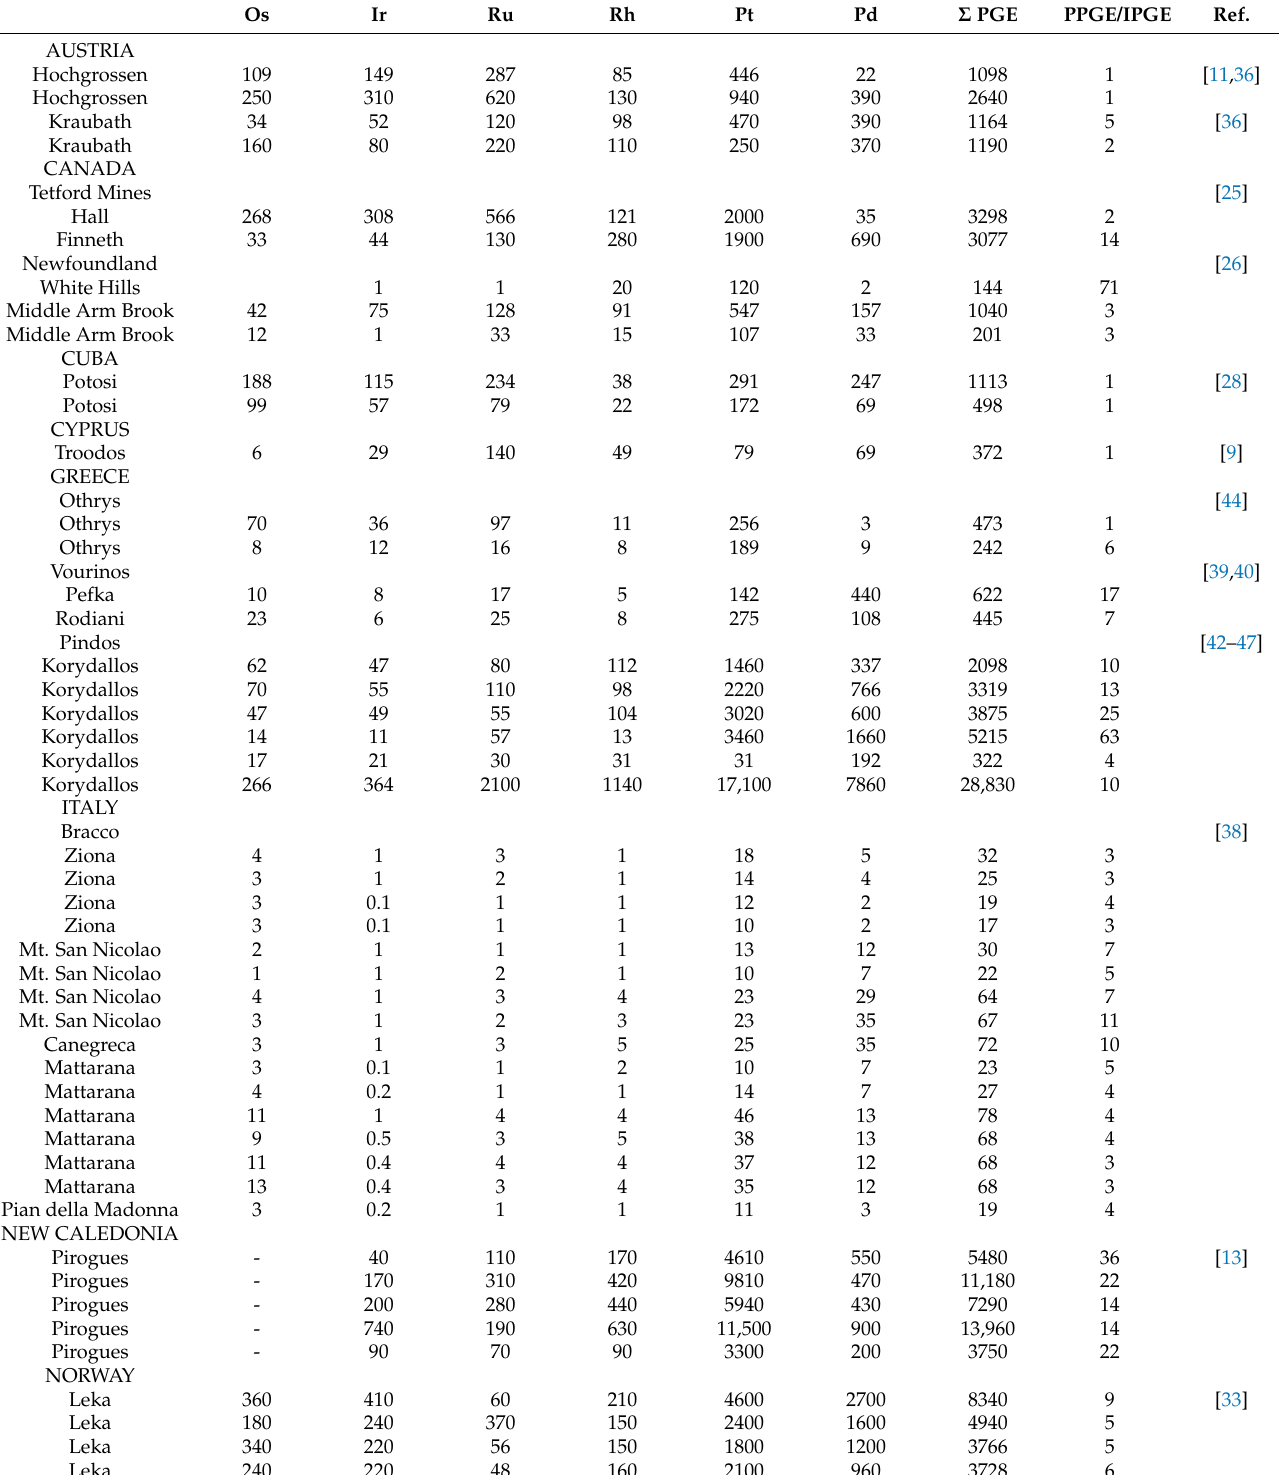
Table 2. Whole-rock PGE analyses (ppb) of ophiolitic chromitites with PPGE-IPGE ratios equal to or higher than